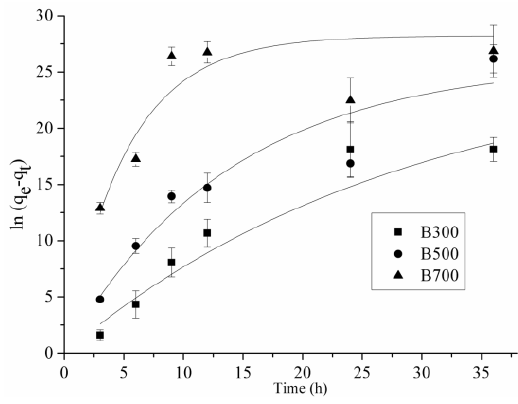
Figure 2. The fitting curve of adsorption kinetics using the Lagergren pseudo-first-order model. Table 2. Fitting results of adsorption kinetics of biochar for chloropicrin (CP).